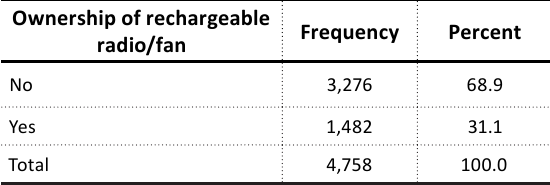
Table 12. Ownership of rechargeable radio/fan